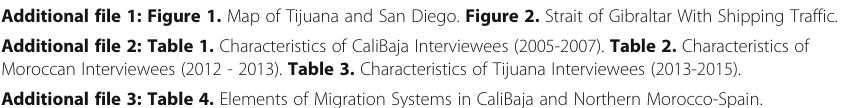
Additional file 3: Table 4. Elements of Migration Systems in CaliBaja and Northern